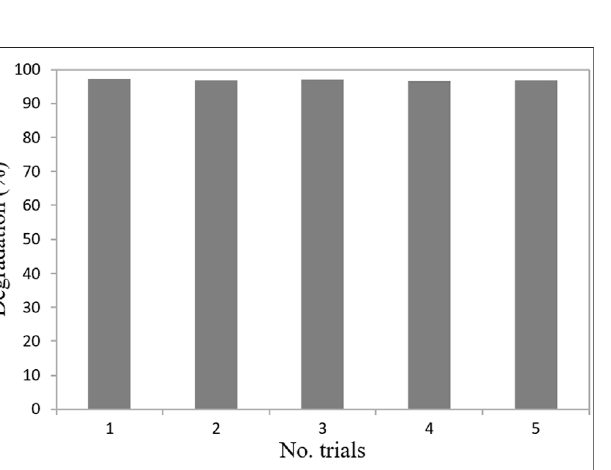
FIGURE 10 | Reuse activity of ZP 19 for RhB dye